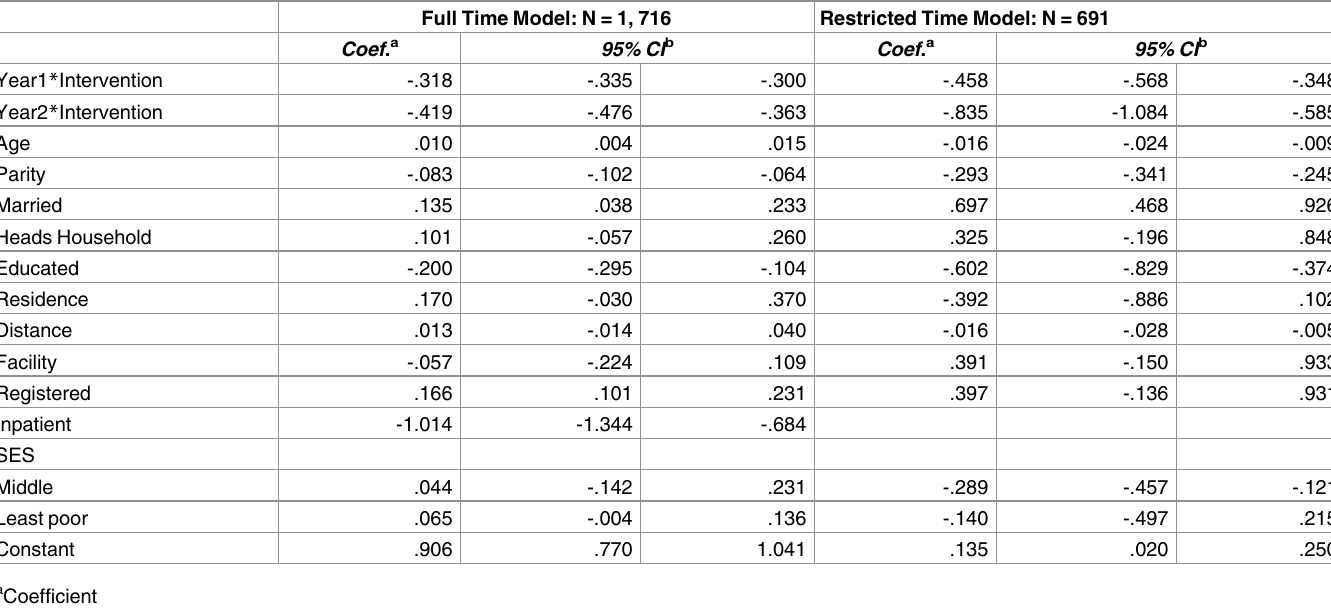
Table 7. Effects of RBF on time to seek care (days) for obstetric complications, adjusted for